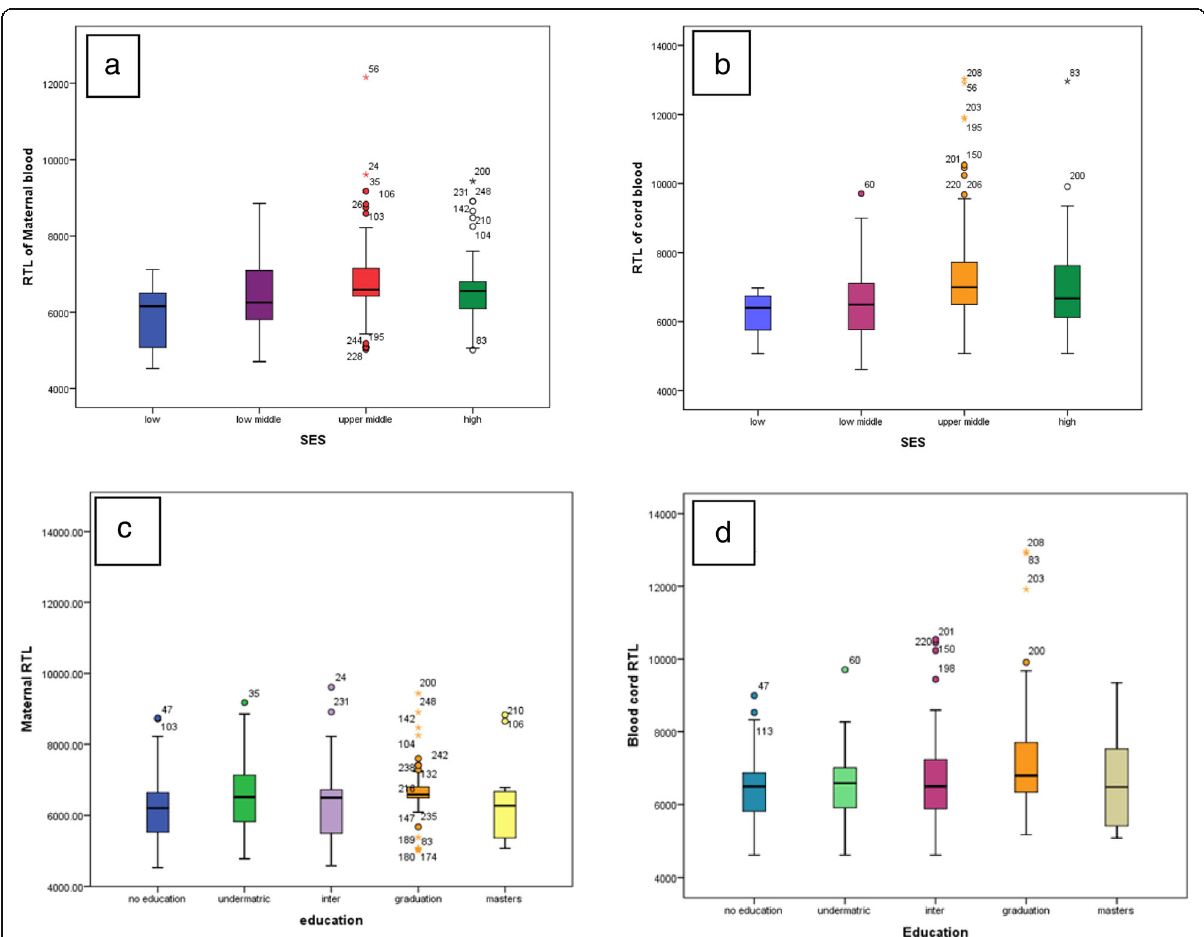
Fig. 2 The Kruskal-Wallis test was used to find mean difference between and maternal and cord blood RTLand SES and education. a Mean difference between SES and maternal blood RTL. b Mean difference between SES and cord blood RTL. c Mean difference between education and maternal blood RTL. d Mean difference between education and cord blood RTL. a Box plots depicted maternal RTL in low SES was shorter compared to upper middle and high SES. Nine outliers are lying in upper middle SES. Box plot ( b ) showed cord RTL was shortest in low SES and upper middle SES had longest with eight outliers (maximum number of outliers). c There were five categories of education groups; all the groups had outliers except masters group, whereas graduation group had longest RTL and no schooling group had smallest RTL. Plots ( d ) illustrated that all the groups had outliers except masters group. Graduation group had longest RTL whereas no schooling had smallest